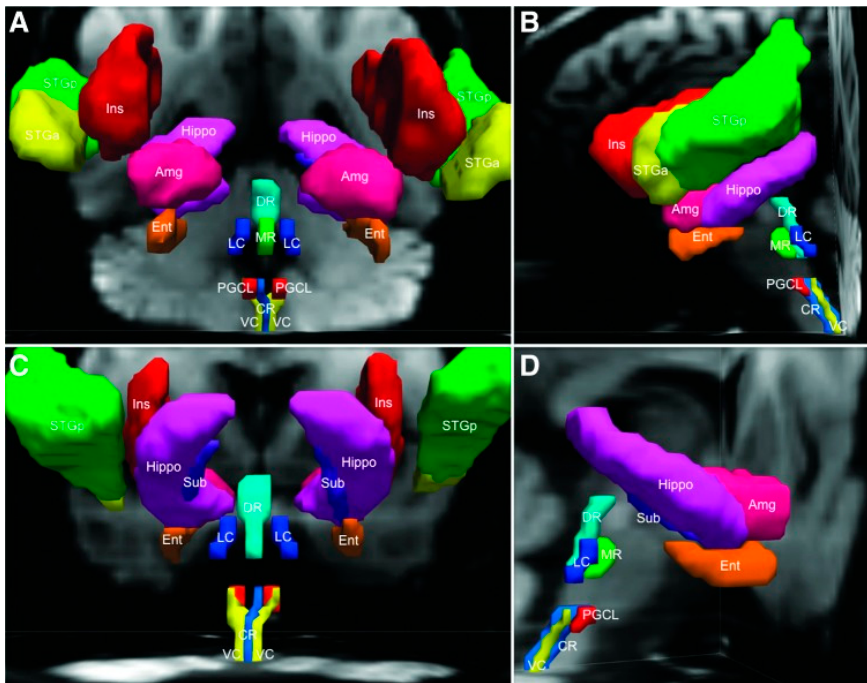
Figure 5. Brainstem seed regions and homeostatic forebrain regions are demonstrated with three- dimensional reconstructions in native diffusion space from an anterior ( A ), left lateral ( B ), posterior ( C ), and right lateral ( D ) perspective. Amg, amygdala; CR, caudal raphe; DR, dorsal raphe; Ent, entorhinal cortex; Hippo, hippocampus; Ins, insula; LC, locus coeruleus; MR, median raphe; PGCL, paragigantocellularis lateralis; STGa, superior temporal gyrus (anterior); STGp, superior temporal gyrus (posterior); Sub, subiculum; VC, vagal complex. Reproduced with permission from [33].